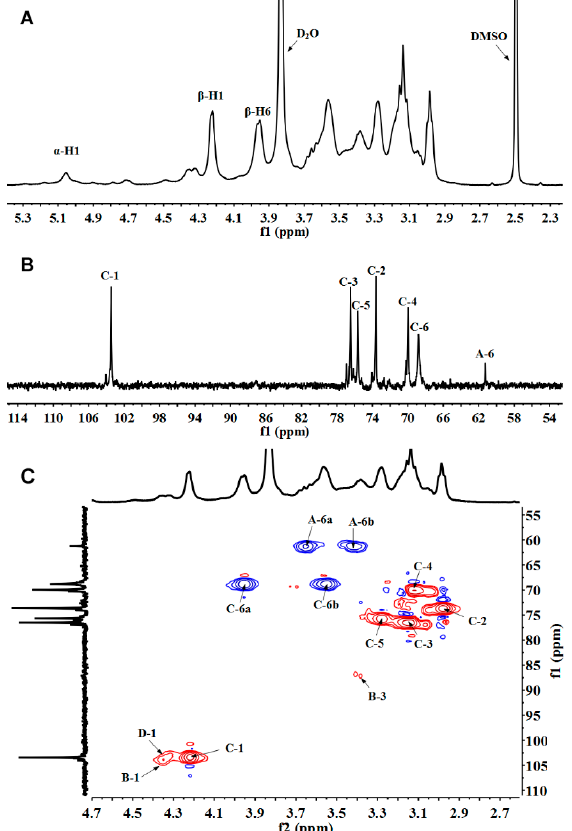
Figure 3. The NMR spectra of LeP-N2: ( A ) 1 H NMR spectrum in DMSO/D 2 O (6:1) at 60 °C; ( B ) 13 C NMR spectrum in DMSO/D 2 O (6:1) at 25 °C; and ( C ) 1 H- 13 C HSQC spectrum. Table 2. The 13 C and 1 H NMR chemical shifts of the main residues from LeP-N2 in D 2 O/DMSO (1:6 v / v ).